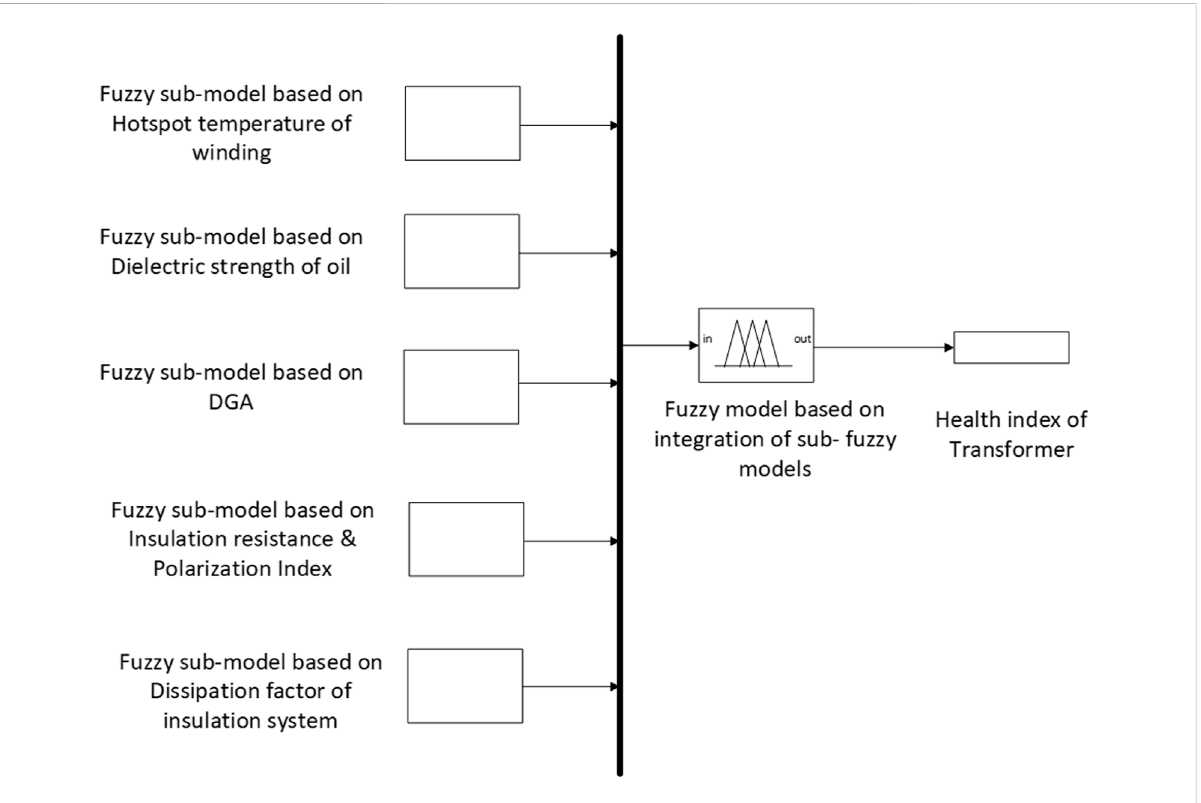
FIGURE 15 Fuzzy sublogic based on